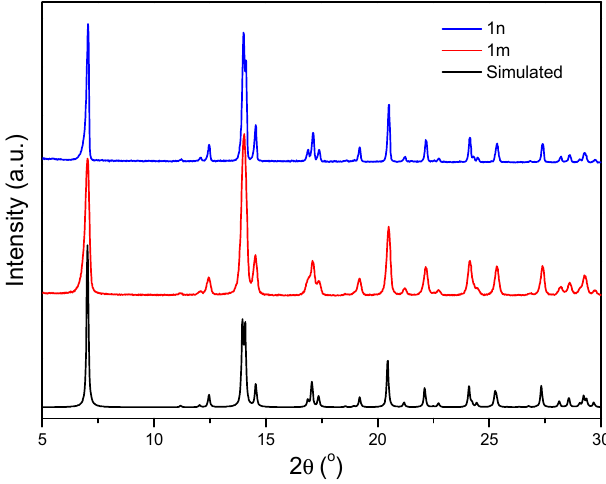
Figure 3. X-ray powder diffraction patterns of simulated from DRX data from the single crystal structural elucidation of {[Cu 2 ( μ 3 -adeninato) 2 ( μ -Hadip) 2 ]} n (black line), ( 1m ) microcrystalline compound (red line), and ( 1n ) submicroparticles (blue line).